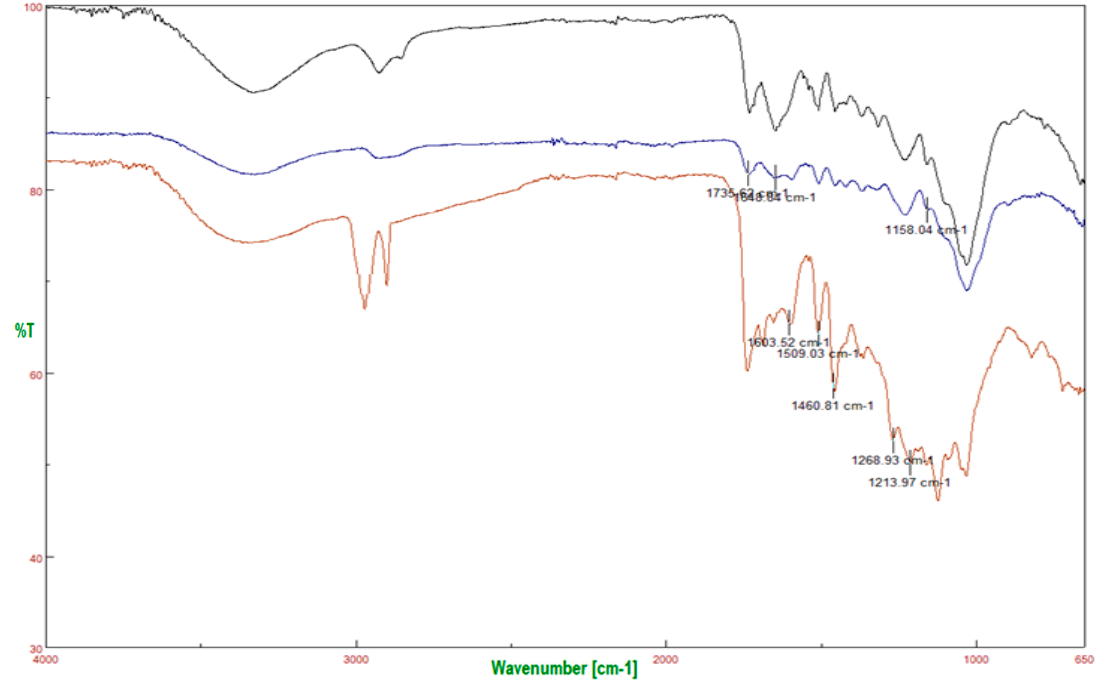
Figure 3. FT-IR spectra of olive pomace before treatment (black line), holocellulose-rich fraction (blue line), and extracted lignin (red line) using [DPTAC][LA]. Table 5. Wavenumber assignments of the characteristics of IR bands of lignin ( A ) and holocellulose-rich fraction ( B ).